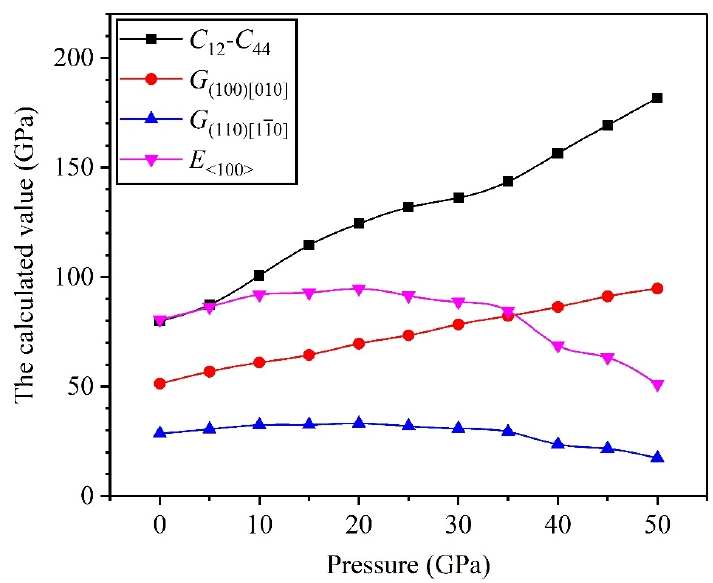
Figure 9. Variation curves of the calculated modulus under different pressures for the NiTi SMA.